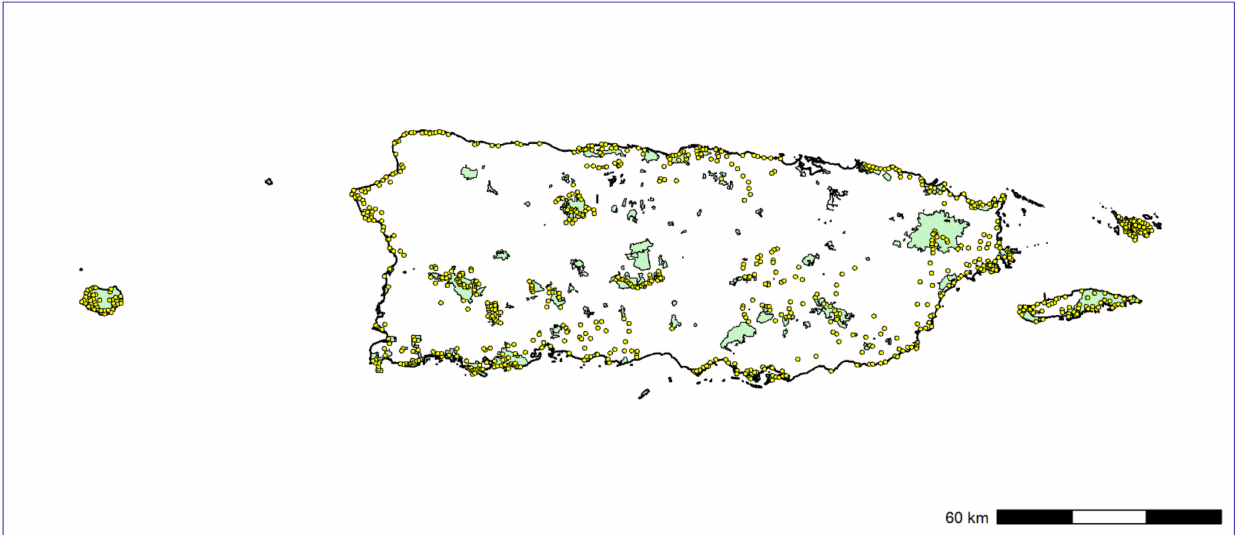
Figure A1. Map of the sampling sites across Puerto Rico from March to July 2021. For each sampling site, an AudioMoth device was deployed. The light-green polygons represent protected